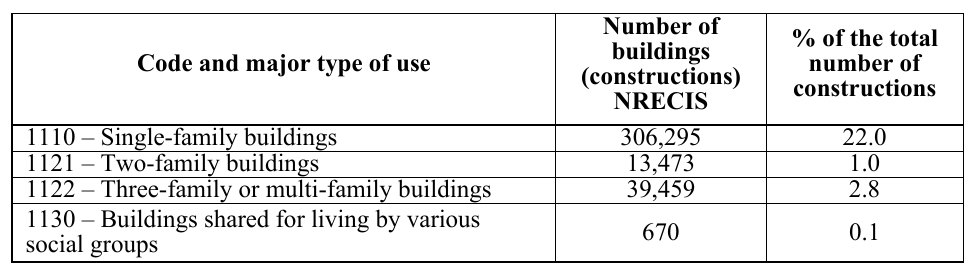
Table 1. The Division of Residential Buildings by Major Type of Use in Latvia as of January 1, 2015 (VZD, 2014 a ) (Number NRECIS; % of the total number of constructions) [Table made by the authors].